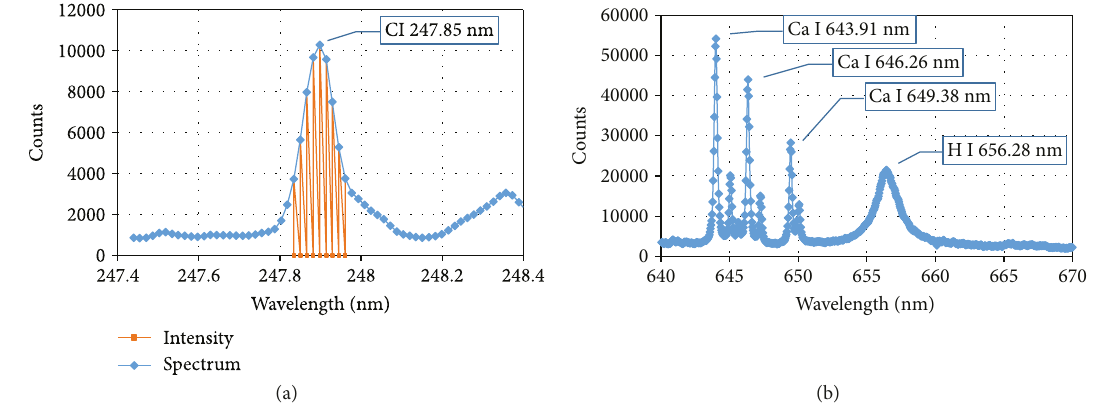
Figure 2: (a) A segment of the spectrum with carbon line (sample 1). (b) A segment with Ca and H